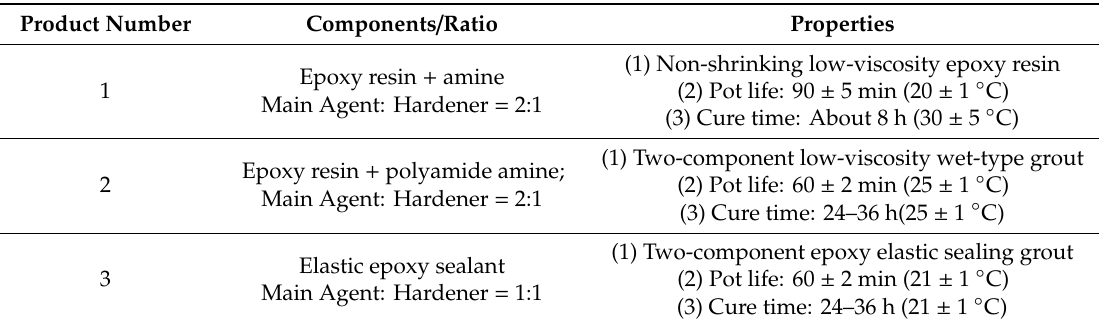
Table 3. The epoxy-resin injection-grout material properties.